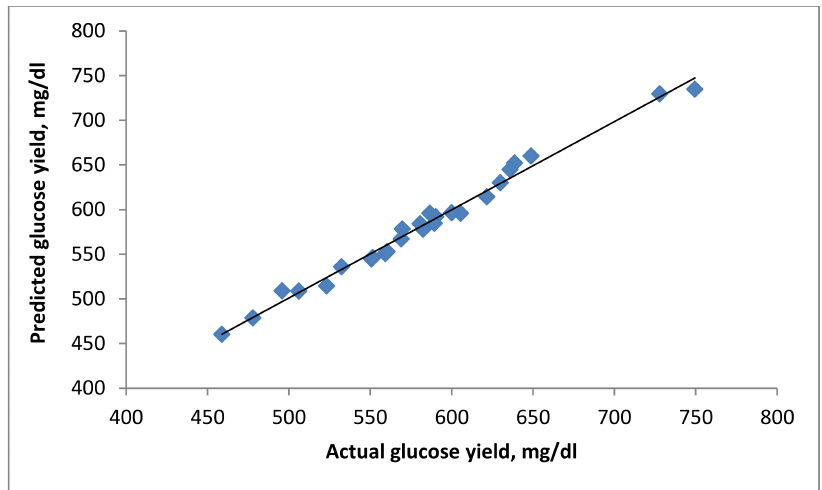
Figure 8. Regression plot between the actual and predicted glucose